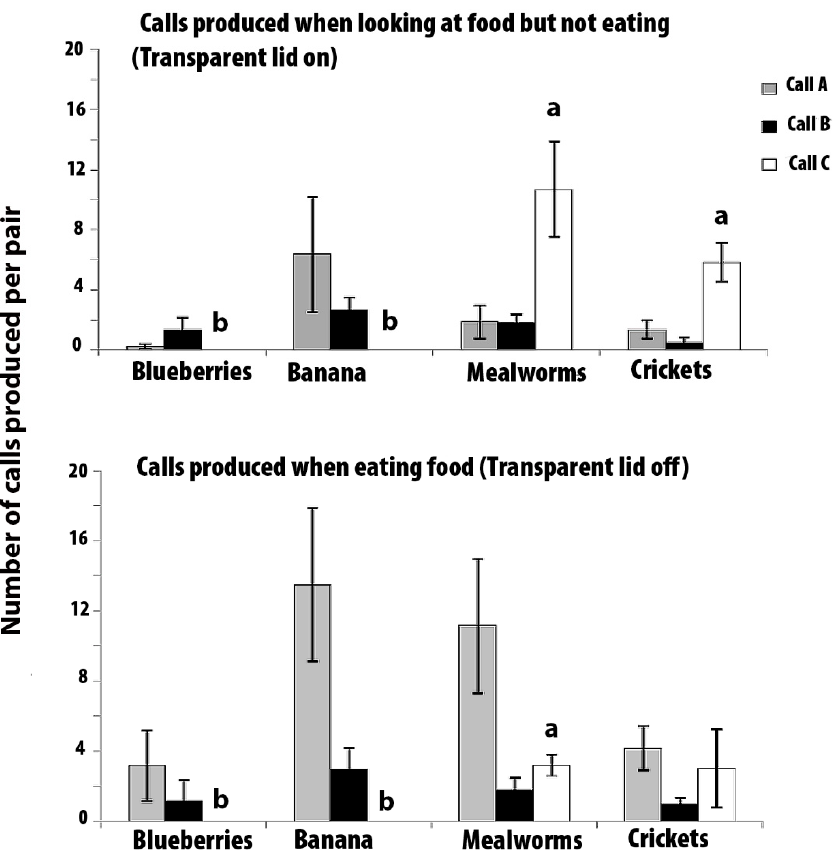
Figure 3. Experiment 2. The mean number of calls produced during the 3 min periods with the transparent lid-on (top graph) and lid-off (bottom graph). The data are for marmosets tested in pairs ( N = 6 pairs). Standard error bars are indicated. Grey bars for Call A, black bars for Call B, and white bars for Call C. Bars marked with ( a ) differ significantly from those marked with ( b